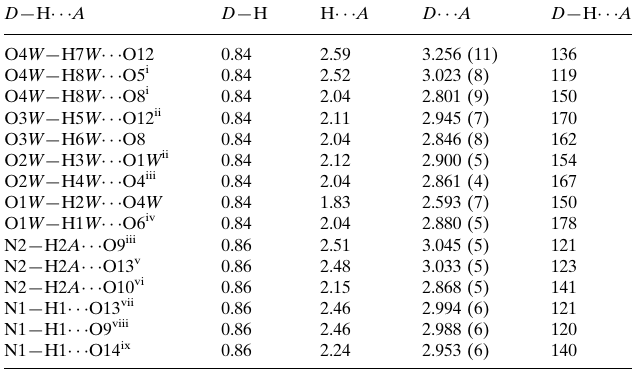
)(C H NO ) (H O) ]- Selected bond lengths (A˚ ). 3 6 5 2 2 2 3 Hydrogen-bond geometry (A˚ , (cid:2) ). D —H (cid:1)(cid:1)(cid:1) A